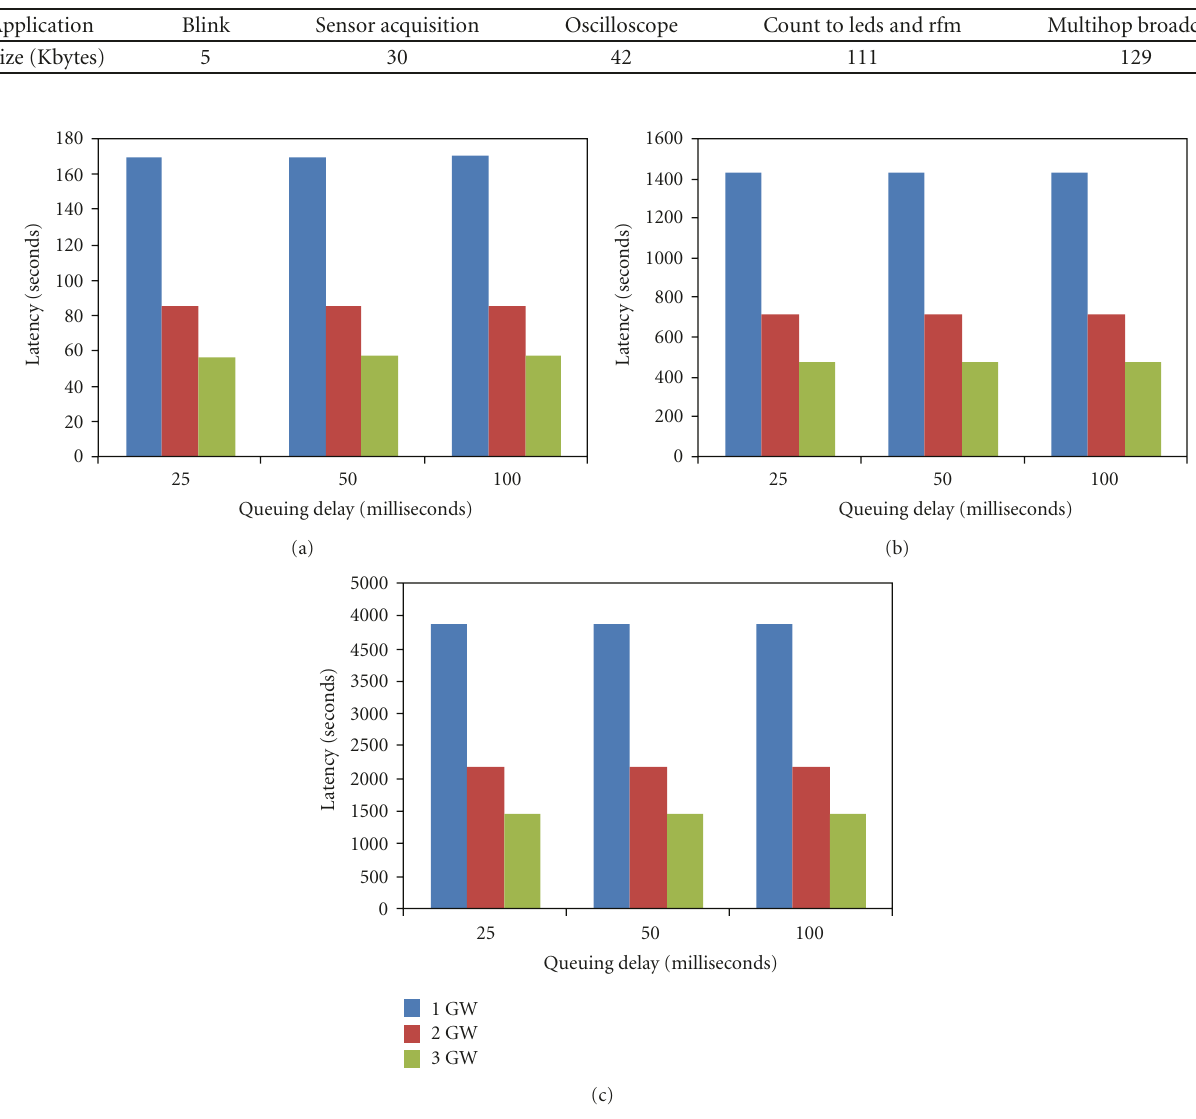
Figure 11: E ff ect of queuing delay on latency of file transfer (wired and wireless links bandwidths 100Mbps and 256kbps) for file sizes (a) 5Kbytes, (b) 42Kbytes, and (c)